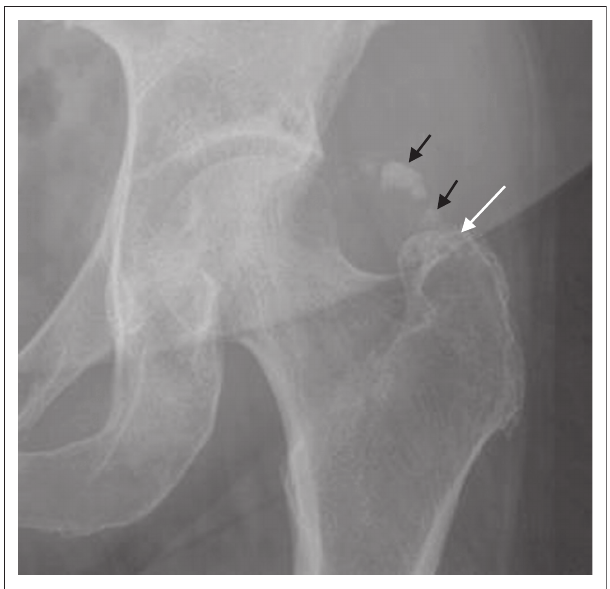
FIGURE 1: Anteroposterior radiograph of the left hip. Globular, poorly defined calcific deposits (short black arrows) above the greater trochanter (long white arrow) ‒ a characteristic site for gluteus medius calcific tendonitis.